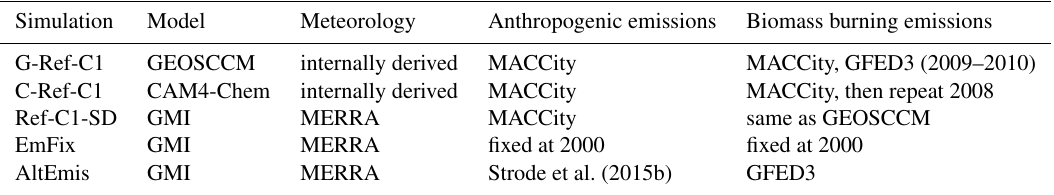
Table 1. Description of simulations.